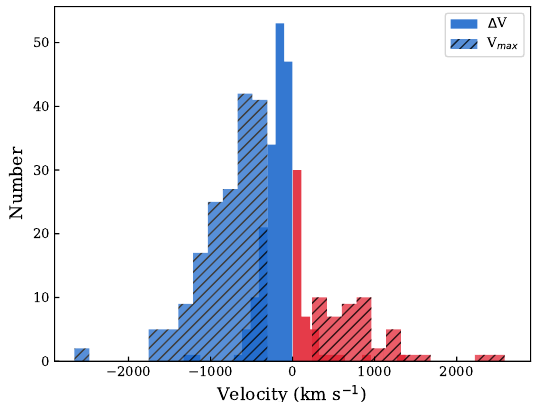
Figure 4. The number distributions of ∆ V and V max for our final sample with outflow signatures. The approaching and receding outflows have been showed in blue and red,